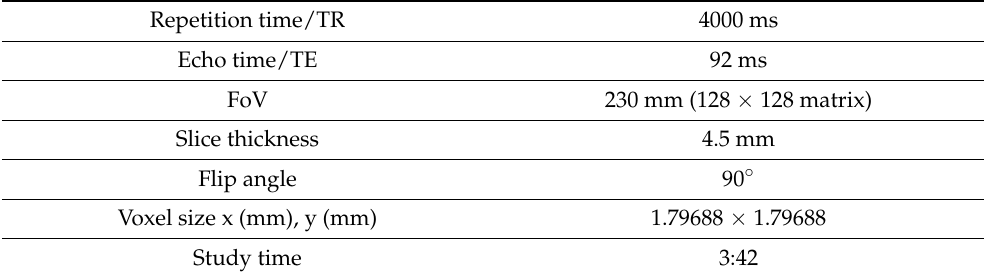
Table 2. Pulse sequence parameters of DTI (2D EPI diffusion